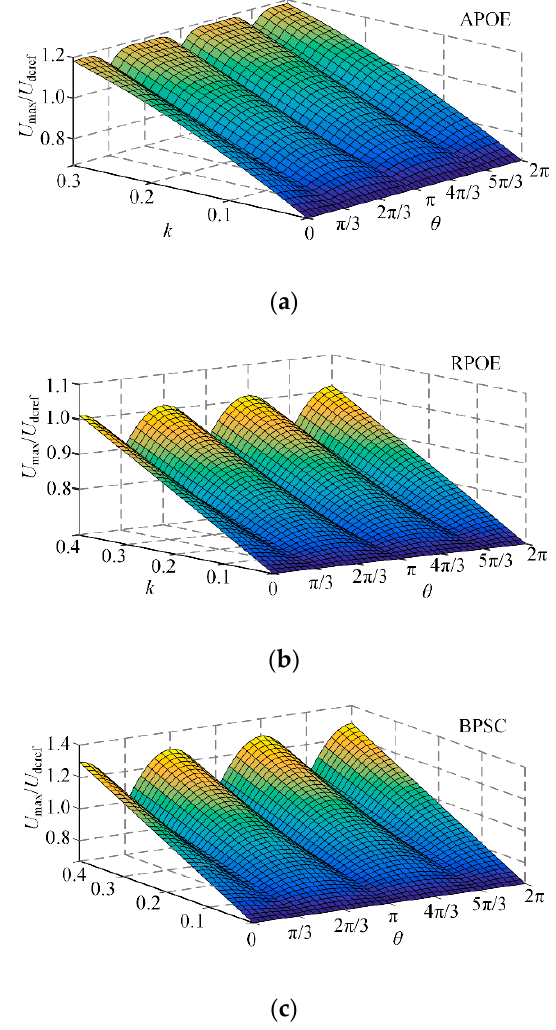
Figure 6. Relationships among the maximum voltage amplitude, unbalanced factor and the phase angle of negative sequence voltage. ( a ) APOE. ( b ) RPOE. ( c ) BPSC. angle of negative sequence voltage. ( a ) APOE. ( b ) RPOE. ( c )